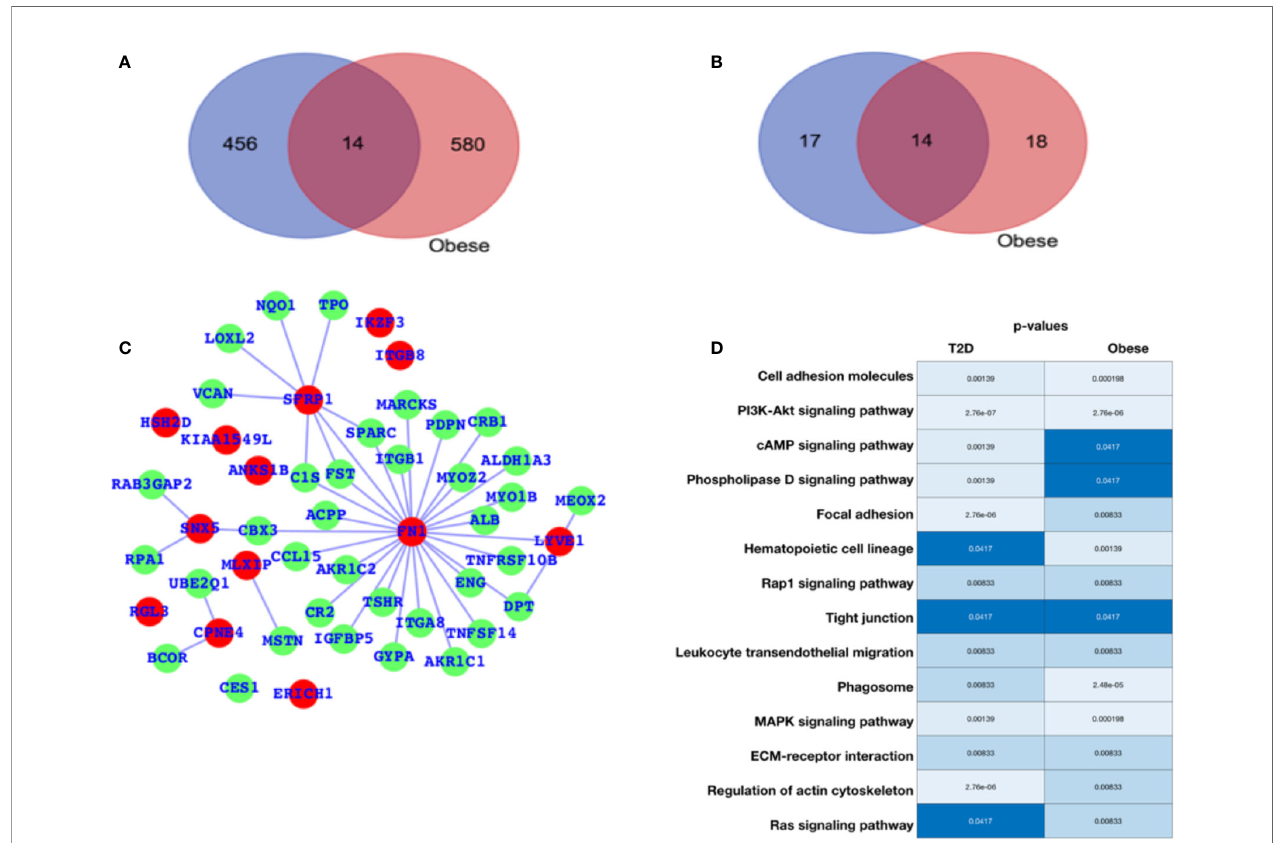
FIGURE 1 | Gene expression pro fi ling. (A) Venn diagram for differentially expressed genes. (B) Venn diagram for enriched pathways. (C) Network representing the DEGs common between T2D and obesity. (D) Commonly enriched pathways: the lighter color or lower p-value refer to higher enrichment, and the darker blue color signi fi es a lower p-value (close to 0.05) and thus lesser enrichment, though all these pathways are signi fi cant in terms of p-values. The p-values are mentioned in the respective color columns and